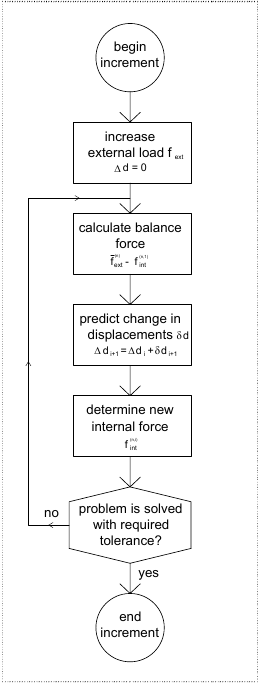
Figure 1. Iteration